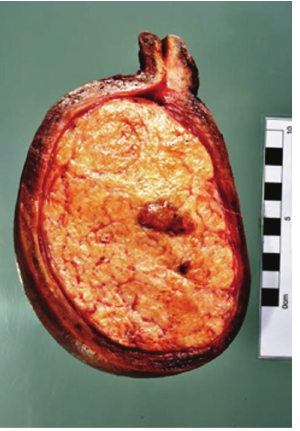
Figure 3: Cross section of uterus with large